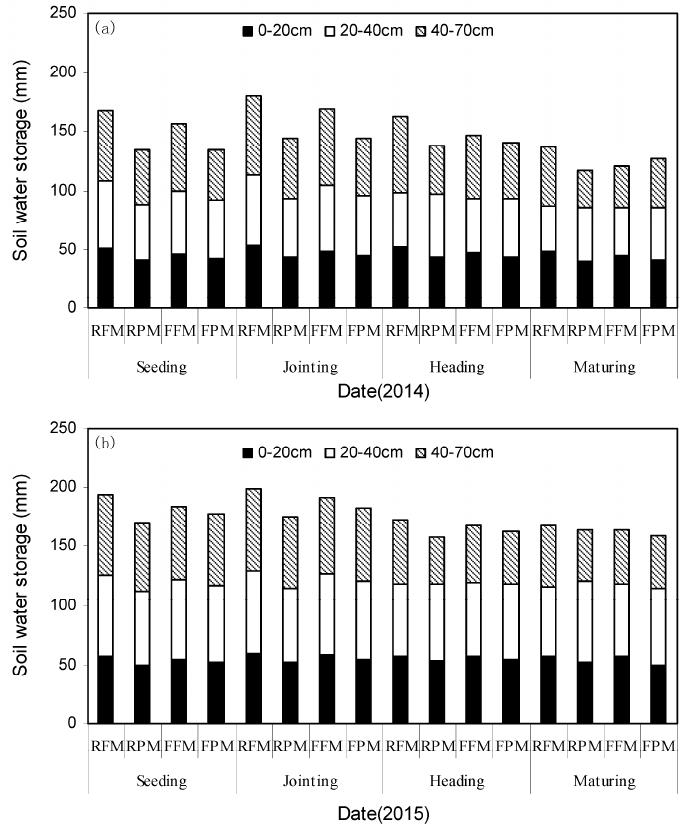
Figure 5. Soil water storage of the 0–70 ‐ cm layer in different treatments during the growth period in 2014 ( a ) and 2015 ( b ).